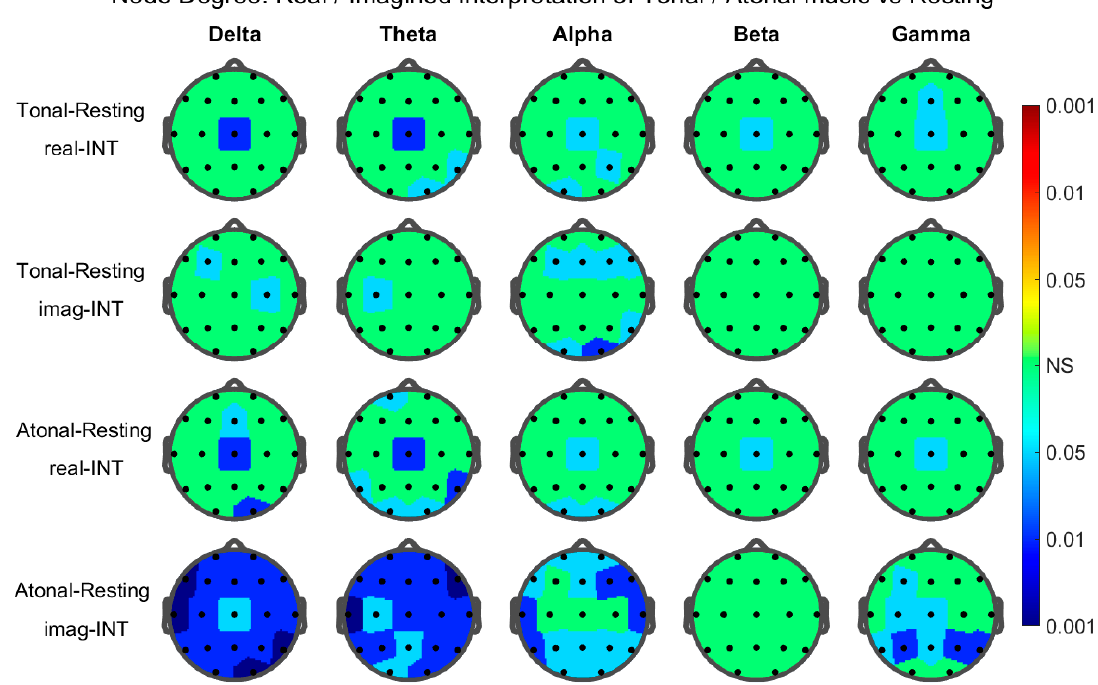
Figure 3. Statistical significance values of the node degree Tonal-Resting or Atonal-Resting difference during real (real-INT) and imagined (imag-INT) interpretations (left column) for the five graphs/head nodes of each EEG frequency band indicated. The color area around each node corresponds to the significance level P in the color bar on the right (valid to all heads); the colors were associated with the three levels of significance ( p < 0.001, p < 0.01, and p < 0.05) by using three ranges of reds when the difference was positive or three ranges of blues when it was negative. NS in green for nodes without statistical significance.